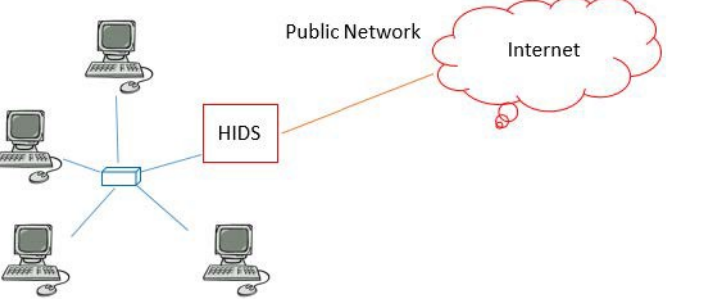
Figure 4. HIDS process: HIDS helps some vulnerable software add a security mechanism. The main purpose of IDS is to detect intrusion activity and send suspicious records to administrators by way of an alarm.